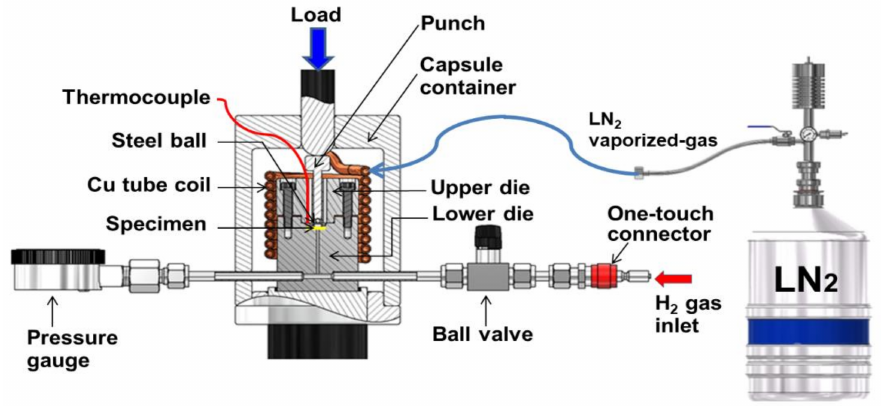
Figure 2. Schematic of the in-situ small punch (SP) test setup used to apply a high-pressure hydrogen environment and a low temperature.